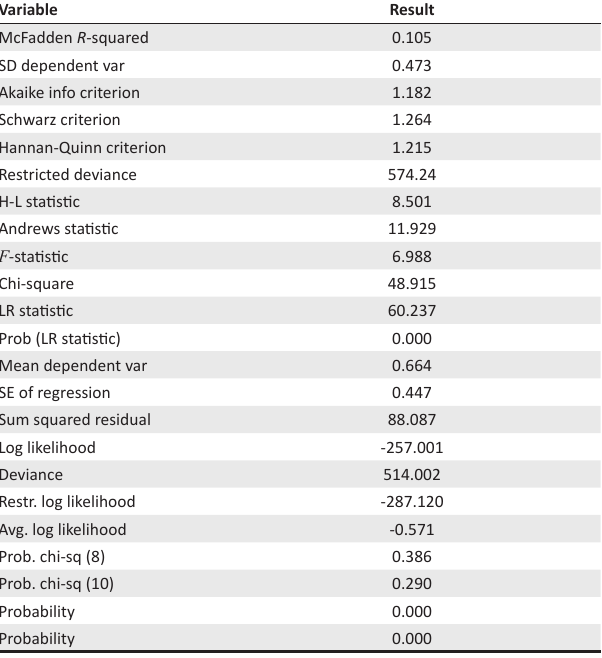
TABLE 3b: Logistic regression results.